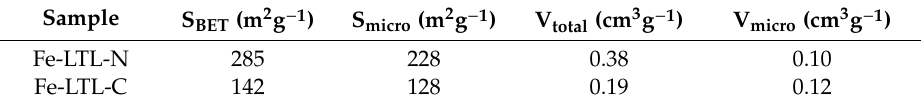
Figure 4. N 2 isotherm sorption of ( a ) Fe-LTL-N, ( b ) Fe-LTL-C. Table 1. Textural parameters of Fe-LTL samples.